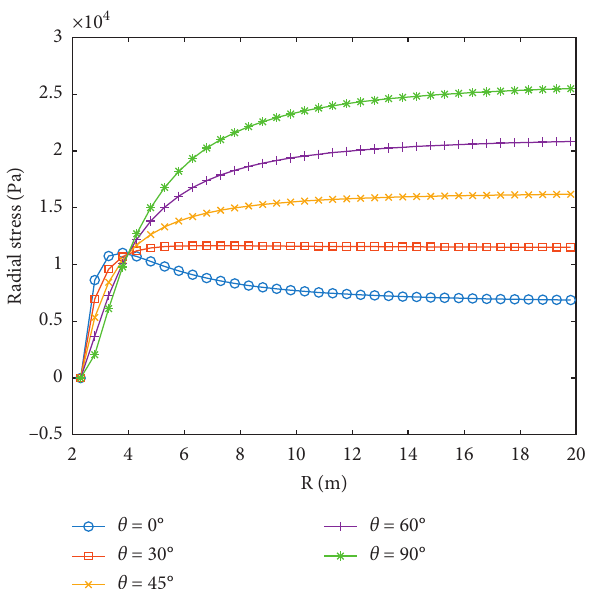
Figure 7: Radial stress at every angle under the in situ stress of surrounding rock.